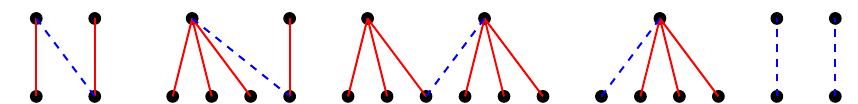
Figure 3.1: Blue dashed edges denote the verification non-equations and continious red edges denote MAC